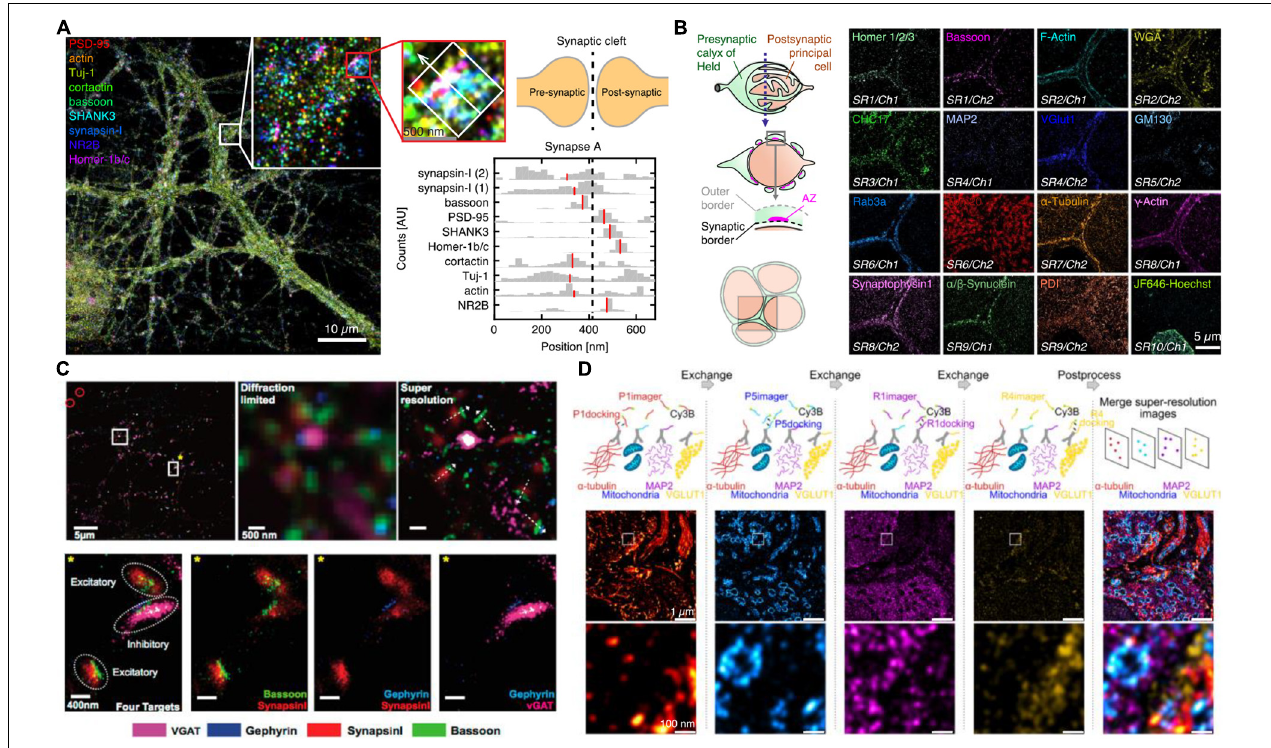
FIGURE 2 | Multiplexed SR imaging of neuronal targets. (A) Super-resolved DNA-PRISM multiplexing of synaptic targets. Left shows an overlayed display of nine targets imaged in neuronal cultures. The targets involve five synaptic proteins, three cytoskeleton proteins and the glutamate receptor subunit NR2B. The right shows cross-sectional profiles of the highlighted individual synapse with the median of the distributions indicated in red. Adapted with permission (Guo et al., 2019). (B) Automated maS 3 TORM imaging of 16 targets in the giant calyx of Held synapse. The targets were subsequently imaged by a fully automated workflow in 10 rounds of staining utilizing one or two different fluorescent channels. Adapted with permission (Klevanski et al., 2020). (C) Exchange-PAINT imaging of four targets in primary neuron culture. Top shows the four-color overlay and zoom-ins with comparison to the diffraction-limited view. By determining the presynaptic and postsynaptic markers for inhibitory and excitatory synapses, the synaptic geometry can be visualized. Bottom shows a magnified view into single excitatory and inhibitory synapses, highlighting the side-by-side clustering of scaffold and marker proteins. Adapted with permission (Wang et al., 2017). (D) Exchange-PAINT imaging of four different targets in a calyx of Held tissue cryosection. Secondary Antibodies carrying four different docking handles were used for spectrally unlimited multiplexing. The middle panel shows the entire field of view with a zoom-in in the bottom panel and the overlayed image on the right side. Adapted with permission (Narayanasamy et al.,